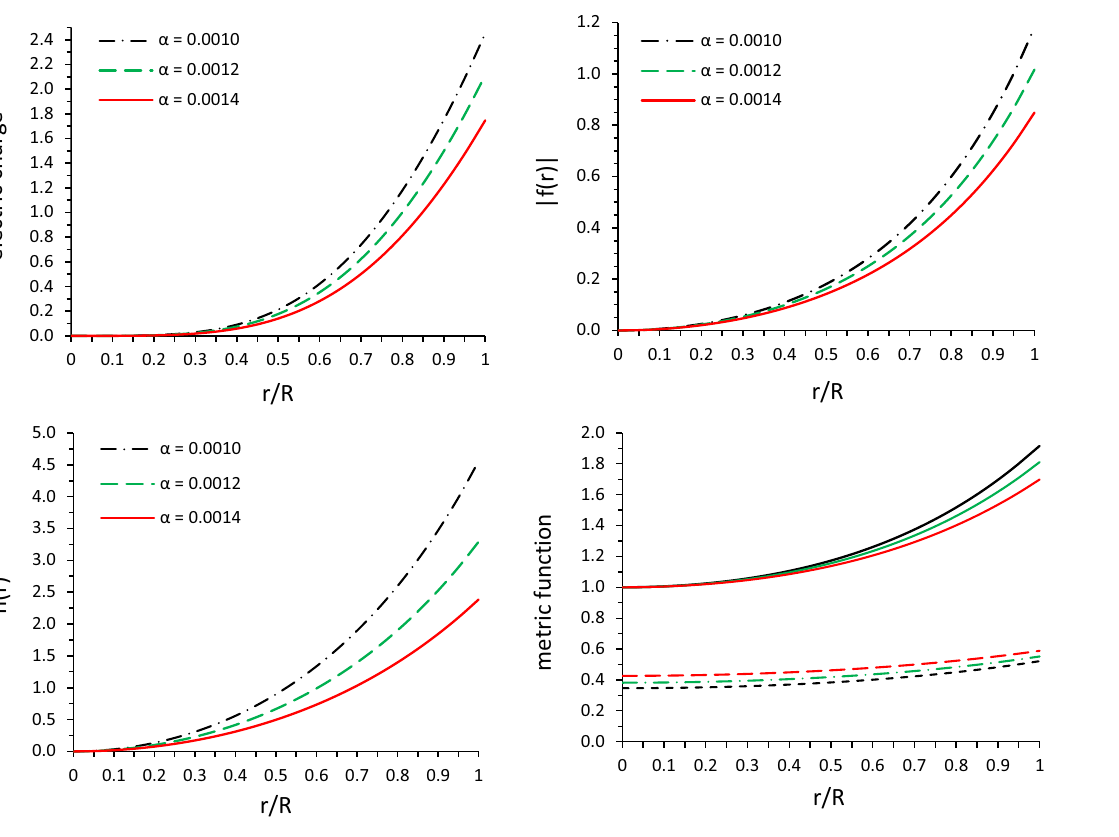
(green curve for α = 0 . 0012), and Cen X-3 (red curve for α = 0 . 0014). For plotting of these figures for each object, we have used the val- ues of free parameters as: a = 0 . 00509, b = 0 . 00002, β = 1 . 8 and γ = 0 .